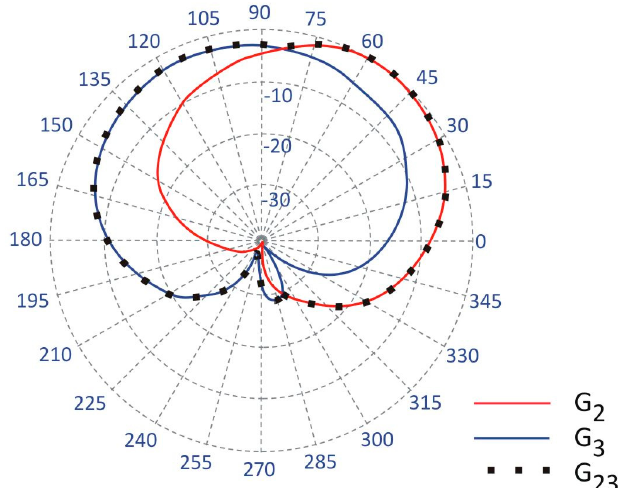
Figure 3. The radiation patterns of antennas in the off-body link obtained for their initial positions ( ϕ 2 = 65°, z 2 = 0.32 m, ϕ 3 = 107°, z 3 = 0.21 m), normalized to the maximum gain value equal to 6.5 dBi.